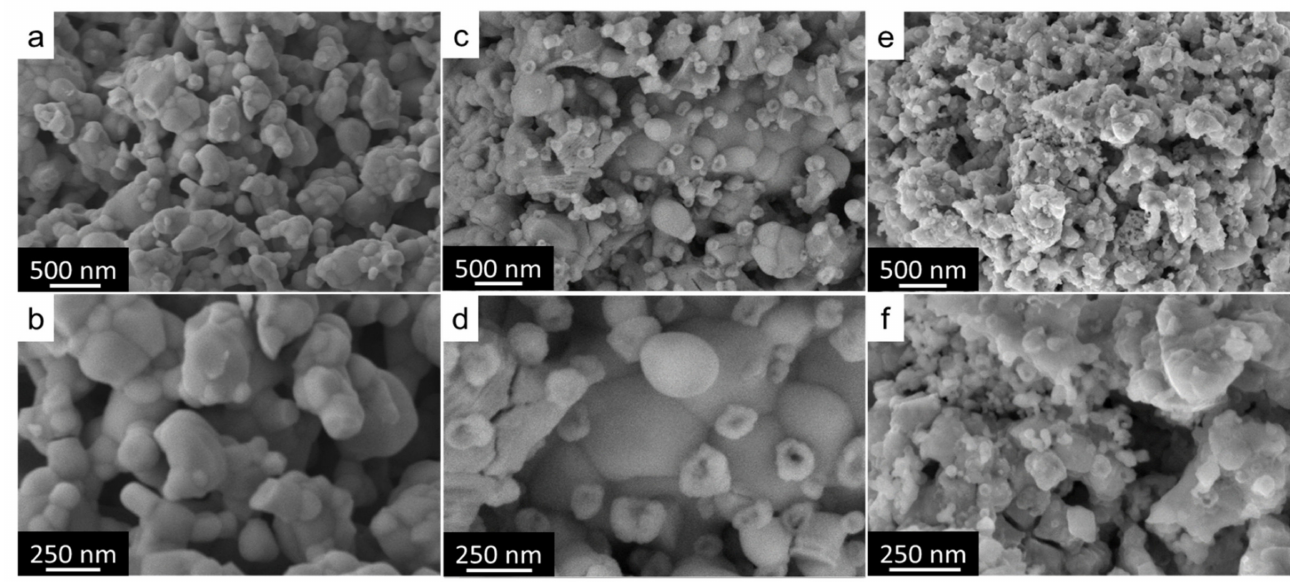
Figure 5. SEM images of ( a , b ) LSCF-SDC baseline composite and LSCF-SDC-nSDC composites comprising: ( c , d ) 5 wt% nSDC and ( e , f ) 18 wt%